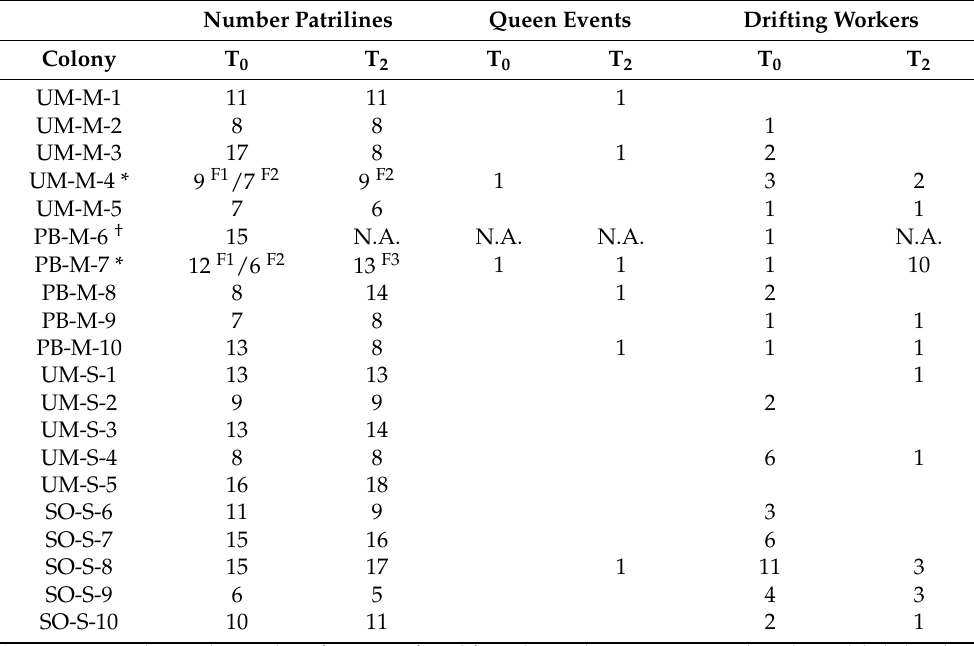
Table 2. Number of patrilines, queen replacement events and drifting workers per colony and sampling times: at the beginning of the experiment (T 0 , except the stationary colonies from Soria (SO-S) that were sampled at T 1 ) and at the end of the migratory period (T 2 ). Colony PB-M-6 † already died off at T 2 ; therefore, data are not available (N.A.). Number Patrilines Queen Events Drifting Workers Colony T 0 T 2 T 0 T 2 T 0 T 2 UM-M-1 11